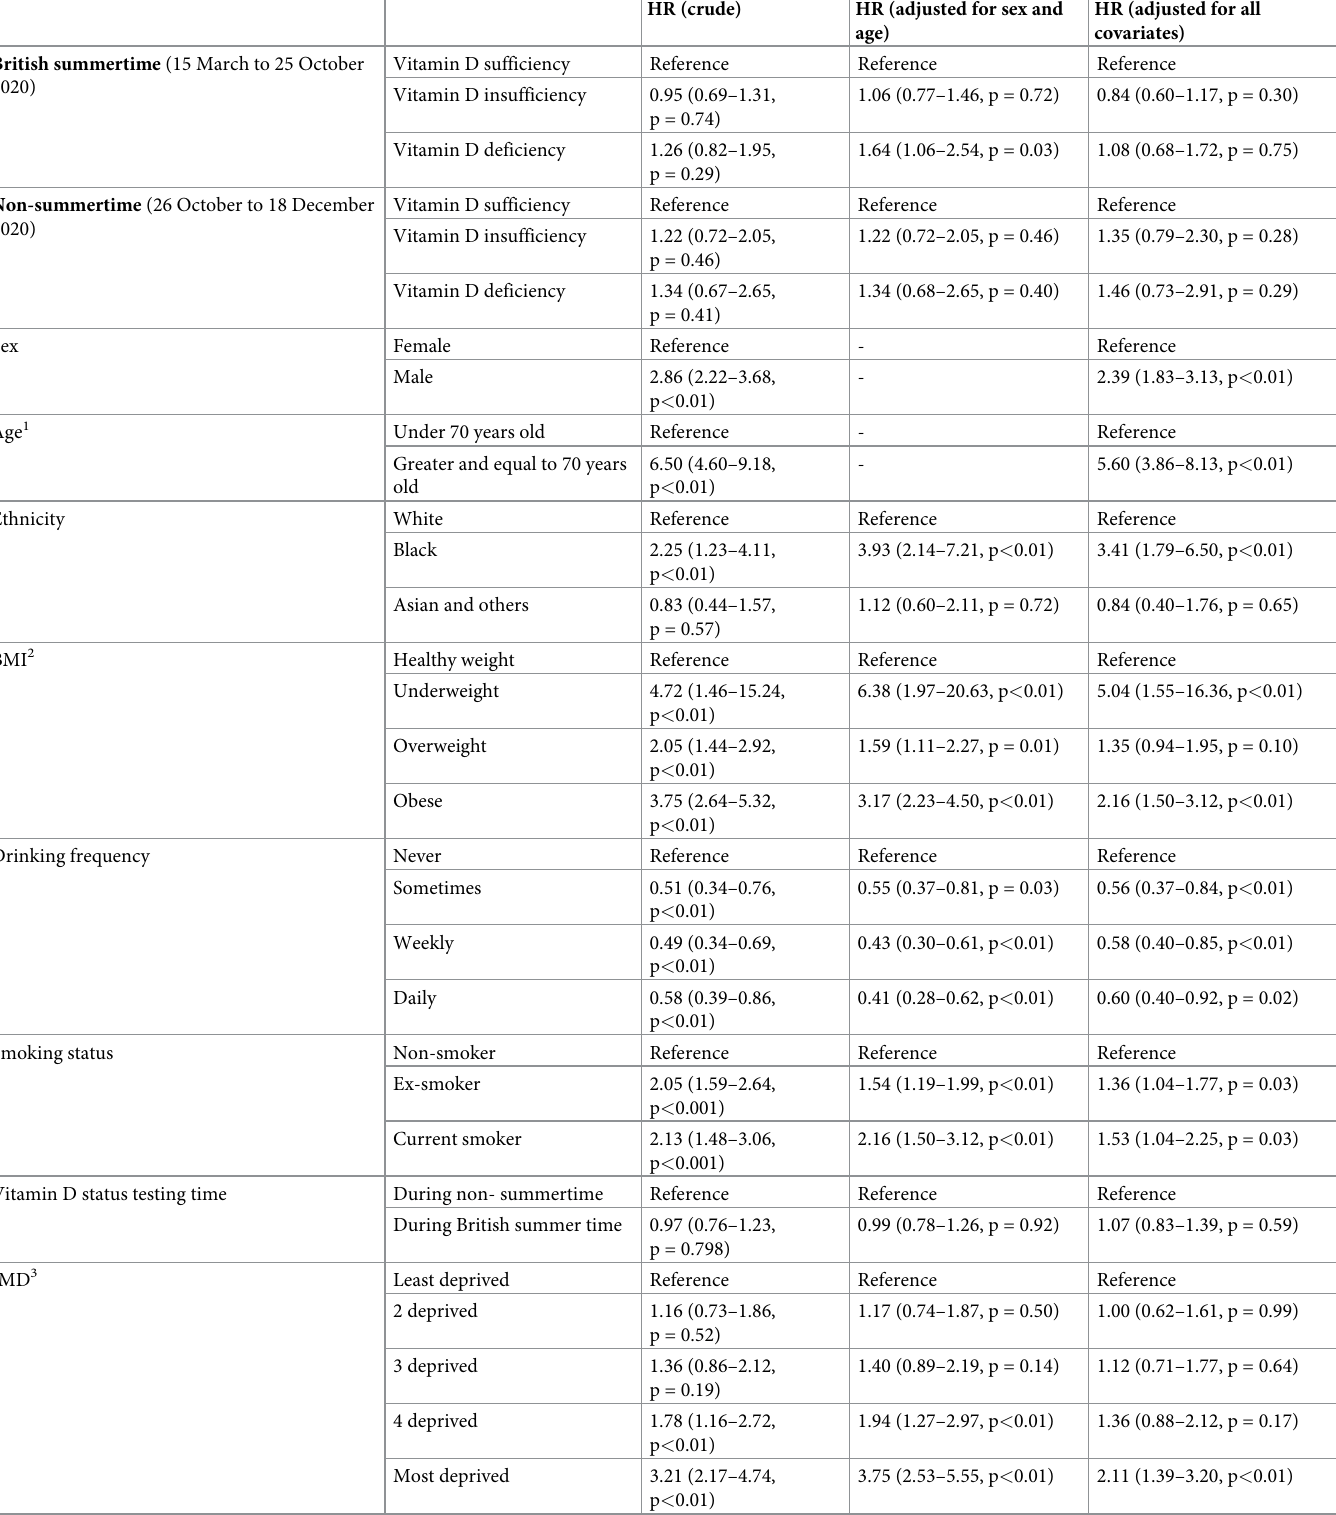
Table 5. The association between vitamin D status and COVID-19 mortality.